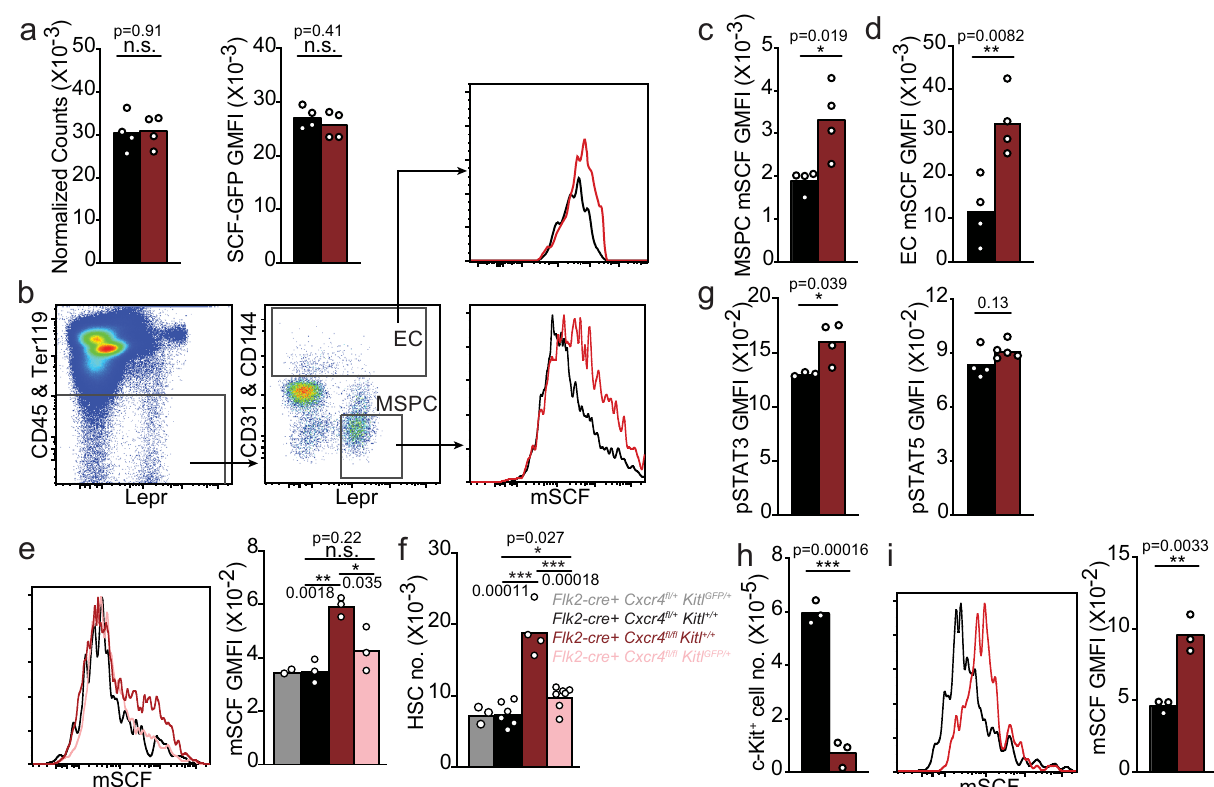
Fig. 6 | Altered membrane-bound SCF on MSPCs and ECs, and altered cKit signaling in HSCs of mice with CXCR4-de fi cient MPPs. a Kitl mRNA expression. Normalized Kitl RNAcountsinMSPCs(left);and Kitl -GFPexpressioningatedLEPR + MSPCs (right) of Flk2-cre.Cxcr4 fl /+ Kitl GFP/+ (black), and Flk2-cre.Cxcr4 fl / fl Kitl GFP/+ (red) mice ( n =4 mice/group). b Gating strategy of LEPR + MSPCs and ECs, and mSCF measurementsby fl owcytometry. c , d mSCFgeometricmean fl uorescent intensity (GMFI) on LEPR + MSPCs ( c ) and ECs ( d ) from Flk2-cre.Cxcr4 fl /+ (black) and Flk2- cre.Cxcr4 fl / fl (red)mice( n =4mice/group). e OverlayofmSCFongatedLEPR + MSPCs isolated from indicated mice (left), mSCF quanti fi cation (right, n =3 mice/group). f HSC numbers in bone marrow. Gray, Flk2-cre.Cxcr4 fl /+ Kitl GFP/+ ( n =3) Black, Flk2-